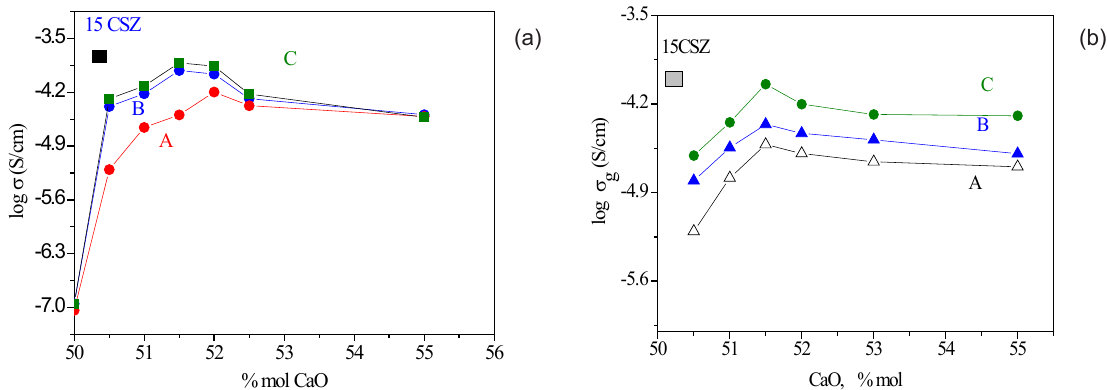
Figure 7. The changes of solubility limit of CaO in CaZrO samples obtained through solid-state reaction as well as the Pechini method.